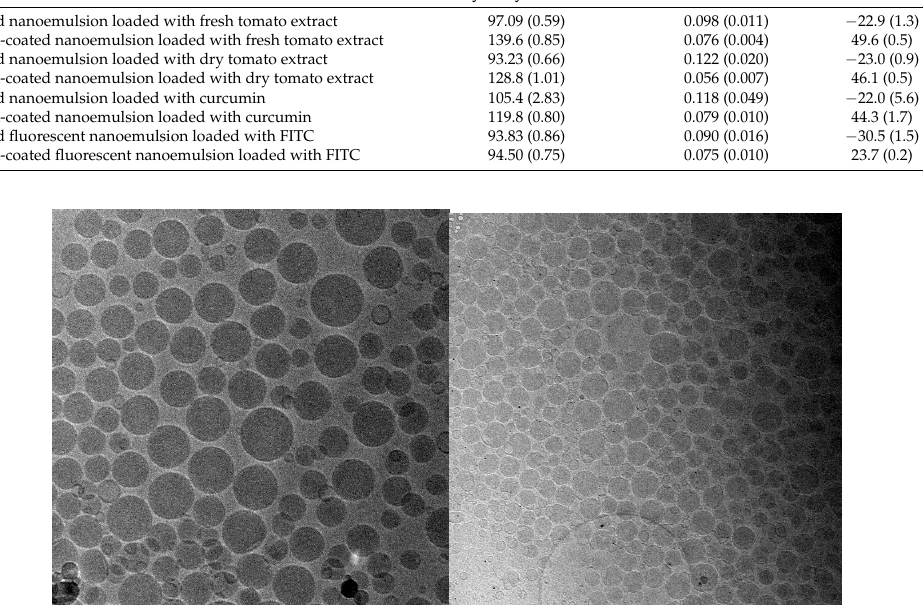
Table 2. Physical–chemical characteristics of nanocarriers used in this study: hydrodynamic size, polydispersity index and ζ potential.